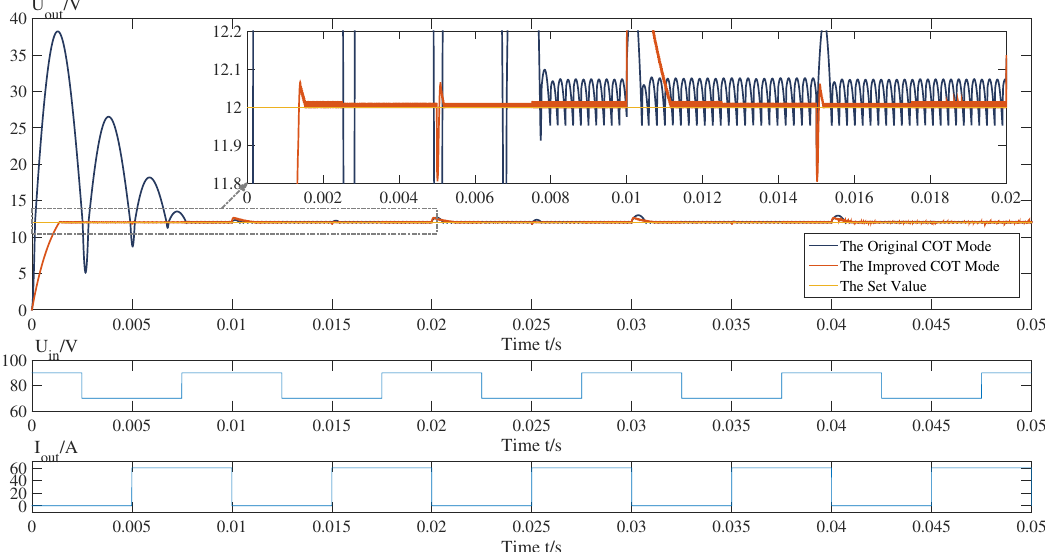
Figure 6. The comparison of the output voltages with the COT and hybrid PD-COT mode. It is worth noting that, when designing a control system, the optimal parameters should be determined by the working conditions, such as U in and R load , and the